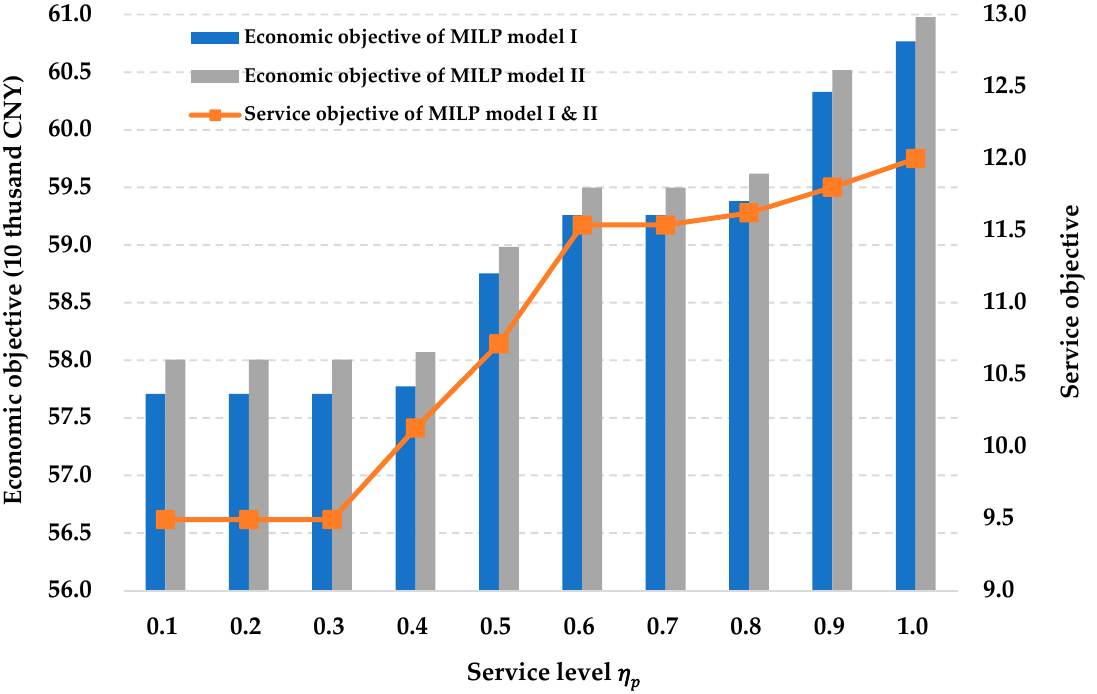
Figure 13. Sensitivity of the routing optimization with respect to the service level ( α = 0.9 and W = 1000).